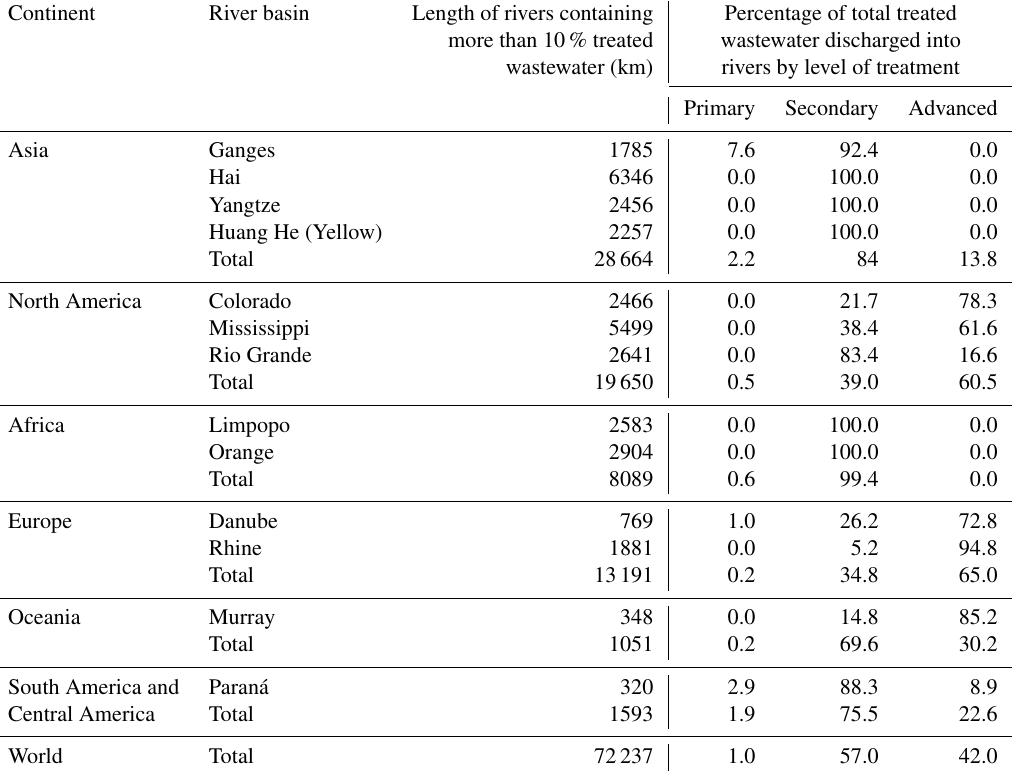
Table 7. Length of rivers containing more than 10% of treated wastewater in their natural average discharge, by continent and for selected basins. The last three columns show the percentage of total treated wastewater discharged into rivers in each basin and continent by level of treatment (i.e., primary, secondary, or